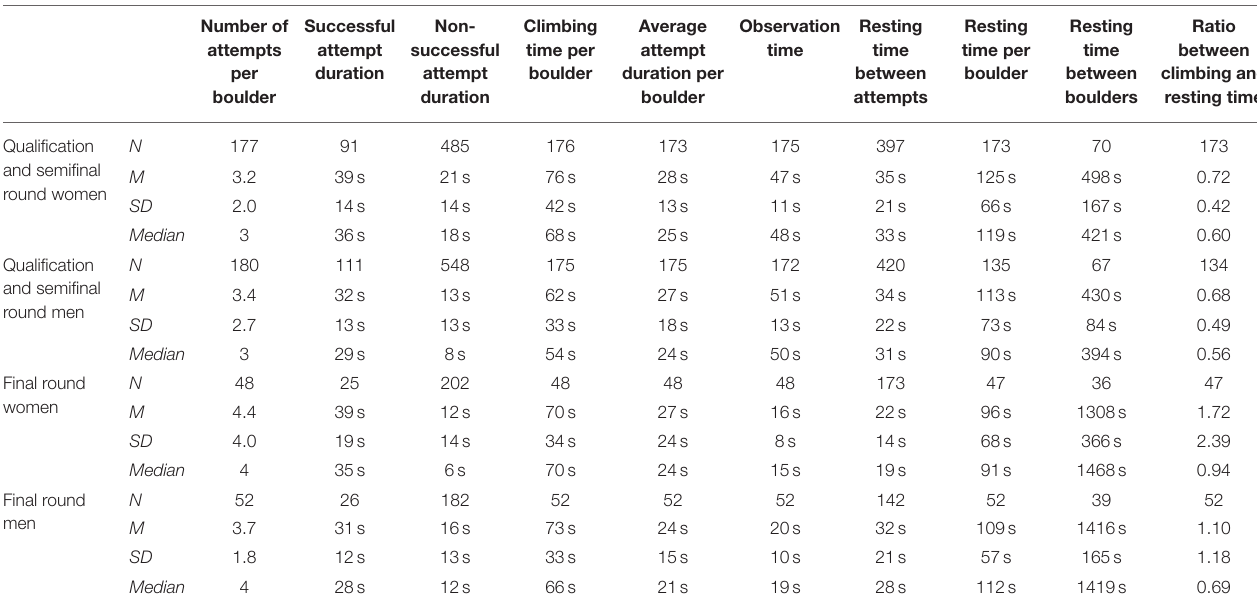
TABLE 3 | Statistics of international bouldering competitions.